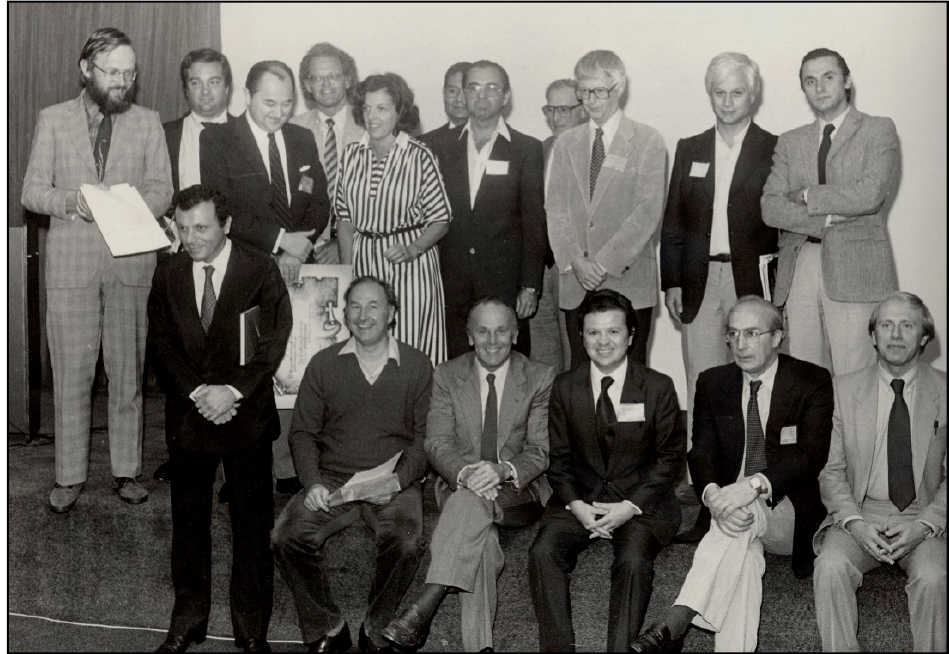
Figure 1. Invited faculty, Brazilian Congress of Pediatric Cardiology, Porto Alegre, 1982.